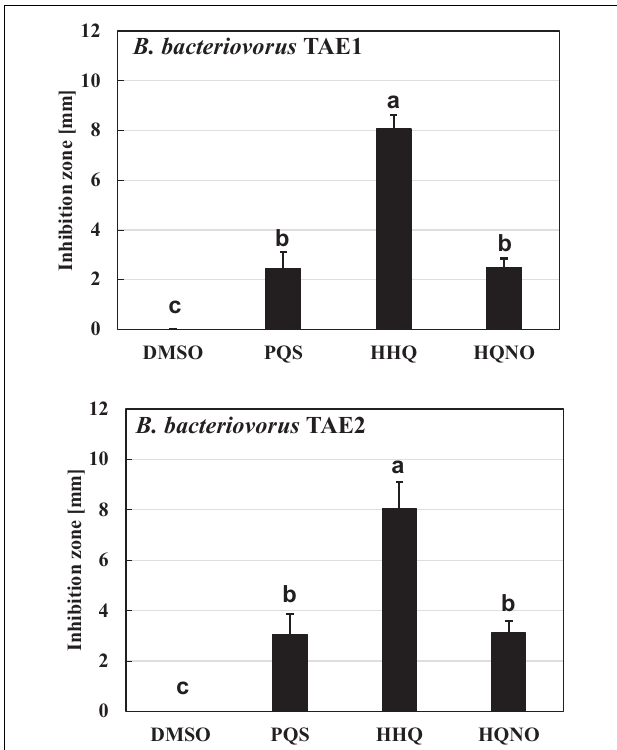
FIGURE 7 | The effect of quinolone compounds on two environmental isolates of Bdellovibrio bacteriovorus . The predation plate assay was conducted using two isolates (TAE1 and TAE2) of B. bacteriovorus . The inhibition zone for the predation plate assay uses a mixture of each B. bacteriovorus isolate, and Escherichia coli BW25113 was compared in the presence of PQS, HHQ, or HQNO compound (16 nmol) placed on the plate after incubation at 30 ◦ C for 4 days. The DMSO sample is the solvent control with DMSO alone. PQS, Pseudomonas quinolone signal, 2-heptyl-3-hydroxy-4(1H)-quinolone; HHQ, 2-heptyl-4-quinolone; HQNO, 2-heptyl-4-quinolinol 1-oxide. n = 3. The value among each sample with different letters is significantly different ( p <